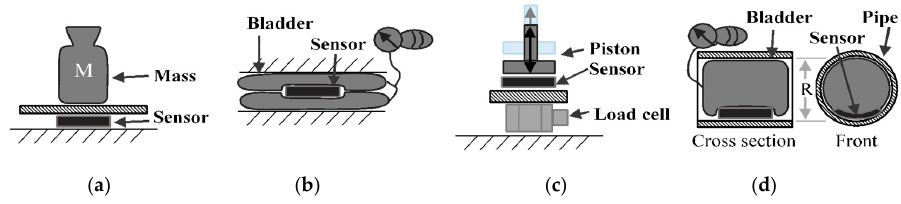
Figure 5. Test configurations for pressure sensor validation. ( a ) Mass Test, ( b ) Bladder Test, ( c ) Piston Test, ( d ) Curvature Test.